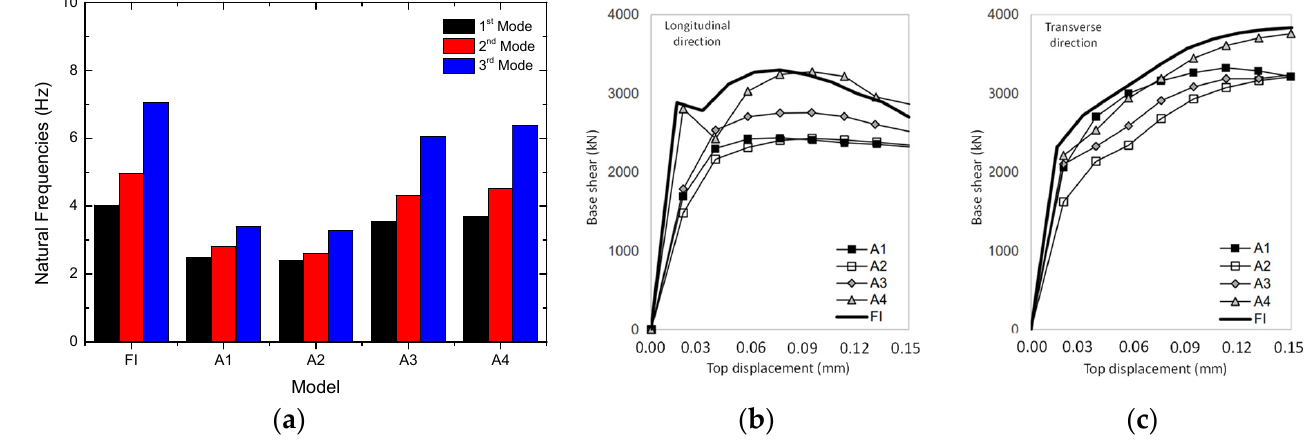
Figure 11. Parametric study A: ( a ) natural frequencies; ( b ) capacity curve (longitudinal direction); and ( c ) capacity curve (transverse direction).